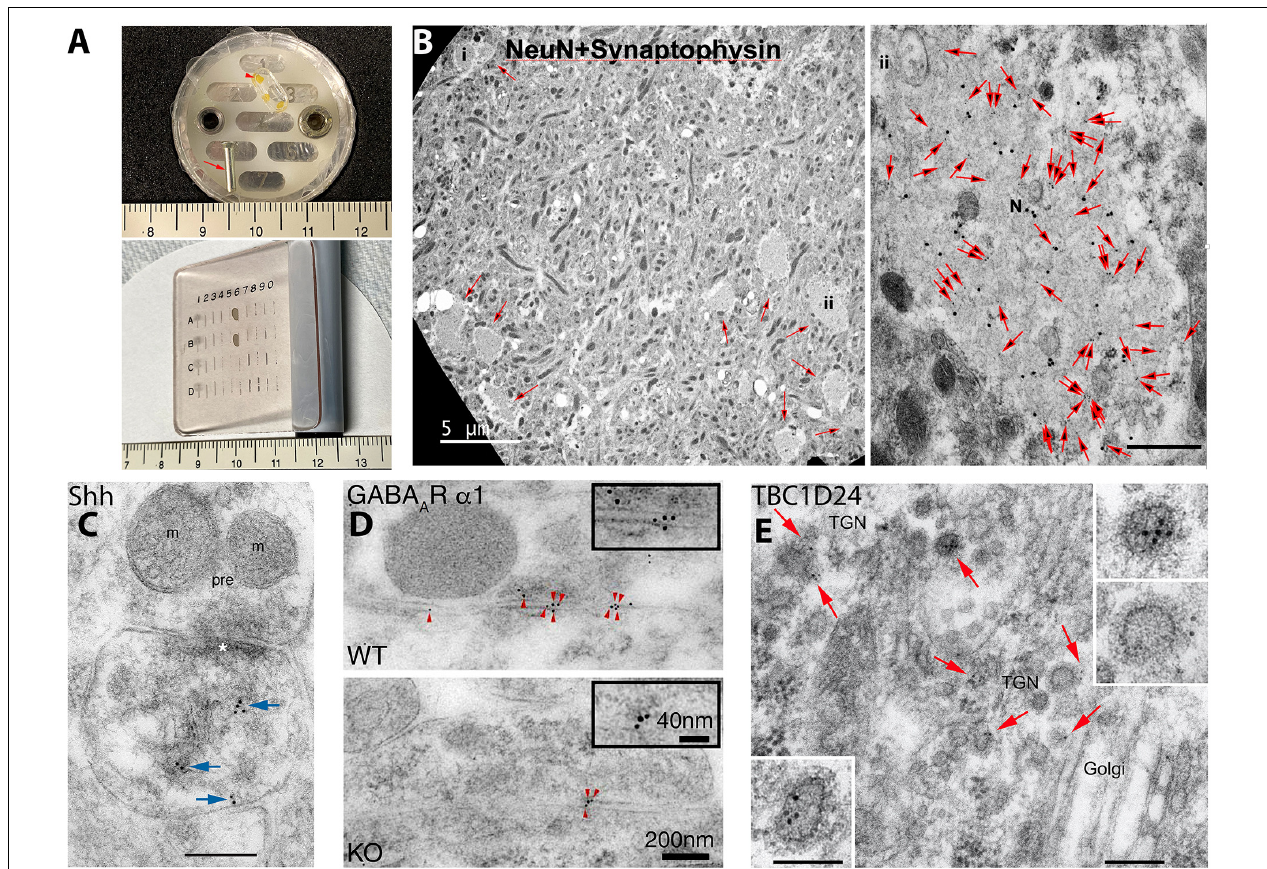
FIGURE 1 | Examples of post-embedding immunogold labeling (PIL) using the protocol presented in the methods of this review. (A) Items used in our PIL method. The top image shows an aluminum peg (arrow) and flat-embedding mold; a sample block with three pieces of brain tissue is included (arrowhead). The aldehyde-fixed and glycerol-cryoprotected tissue is placed on double-stick tape on the peg and plunged into liquid propane in a Leica CPC. Then the frozen tissue is placed in the flat-embedding mold in the Leica AFS in a solution of methanol and uranyl acetate at − 90 ◦ C. After infiltration with cold Lowicryl, embedding is finished with UV polymerization. Note that the embedded tissue is yellow due to the uranyl acetate. Tissue blocks are sectioned on an ultramicrotome and the thin sections placed on grids, and then immunogold-labeled while attached to a Hiraoka support plate (bottom image); note that labeling will occur on both sides of the section. See text for more details. Centimeter rulers are shown in images. (B) Novel clusters of large, NeuN-positive, degenerate, swollen presynaptic terminals (N; small arrows in left image) are found in the CA1 region of the hippocampus in 12-month-old mice. They are more common in DPP6-KO mice (shown); DPP6 is an auxiliary subunit of a voltage-gated potassium channel. In these swollen terminals, NeuN (20 nm gold) completely colocalizes with the presynaptic terminal protein, synaptophysin (10 nm gold; all 10 nm gold particles in the micrograph are indicated with large arrows in the right image) and labeling for both proteins is low outside of the swelling; this is consistent with light microscope observations. The location of the high magnification image (labeled #ii) is indicated in the lower right area of the low magnification image on the left. The scale bar on the right image is 500 nm. From Figure 4 of Lin et al. (2020; open access-http://creativecommons.org/licenses/by/4.0/). (C) PIL (10 nm gold; arrows) of sonic hedgehog (Shh) in the CA1 region of the mouse hippocampus, showing labeling associated with postsynaptic tubulovesicular structures and the spine membrane. m, mitochondrion; pre, presynaptic terminal; asterisk, postsynaptic density. The scale bar is 200 nm. From Figure 4 of Rivell et al. (2019; open access). (D) PIL (5 nm gold; arrowheads) of the GABA A α 1 receptor at inhibitory synapses in the CA1 region of the mouse hippocampus, showing a significant reduction in labeling in the Shisa7 KO compared to WT; Shisa7 is a GABA A receptor auxiliary subunit protein that controls benzodiazepine actions. From Figure 2 of Han et al. (2019; AAAS). (E) PIL (10 nm gold; arrows) of TBC1D24 in the CA1 region of the mouse hippocampus, showing a concentration of labeling in clathrin-coated vesicles of the trans-Golgi network (TGN) in neuron somas. TBC1D24 mediates vesicle trafficking important for neuronal signal transmission, and its mutations are associated with epilepsy, deafness, and other disorders. Scale bars are 200 nm for the lower-magnification and 100 nm for the higher-magnification insets. From Figure 4 of Tona et al. (2019; Oxford University Press). Note for (D,E) , that AAAS and Oxford University Press, respectively, as stated in the author information, permit authors to use figures from their previously published works in subsequently published